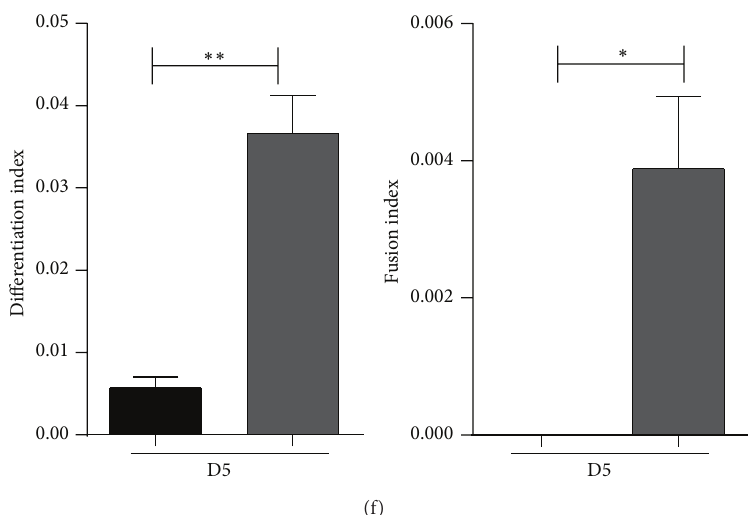
Figure 7: The acquisition of fibro-adipogenic features involves a HDAC-regulated network. (a) Upper panel shows western blot analysis of HDAC4 expression in C2C12 and C2C12 MLC/SOD 1 G 93 A cells and densitometric analysis (lower panel) of the ratio between HDAC4 and 𝛼 -tubulin. (b) Real time PCR for BAF60C in C2C12 (white bars) and C2C12 MLC/SOD 1 G 93 A (black bars). (c, d) Histograms of the percentage of Sca1 (c) and positive 𝛼 7 integrin cells (d) of control C2C12 MLC/SOD 1 G 93 A (black bars) cells and TSA treated C2C12 MLC/SOD 1 G 93 A cells (grey bars). D2 referred to days of culture in differentiation condition. (e) Representative immunofluorescence analysis for MHC after 5 days in differentiation medium in untreated (left panel) and TSA treated (right panel) C2C12 MLC/SOD 1 G 93 A cells. (f) Histograms of the differentiation index (left panel) and fusion index (right panel) in control (black bars) and treated cells (grey bars). D2 and D5 referred to days of culture in differentiation condition. Data are represented as mean ± SEM ( ∗ 𝑃 < 0.05 ; ∗∗ 𝑃 < 0.005